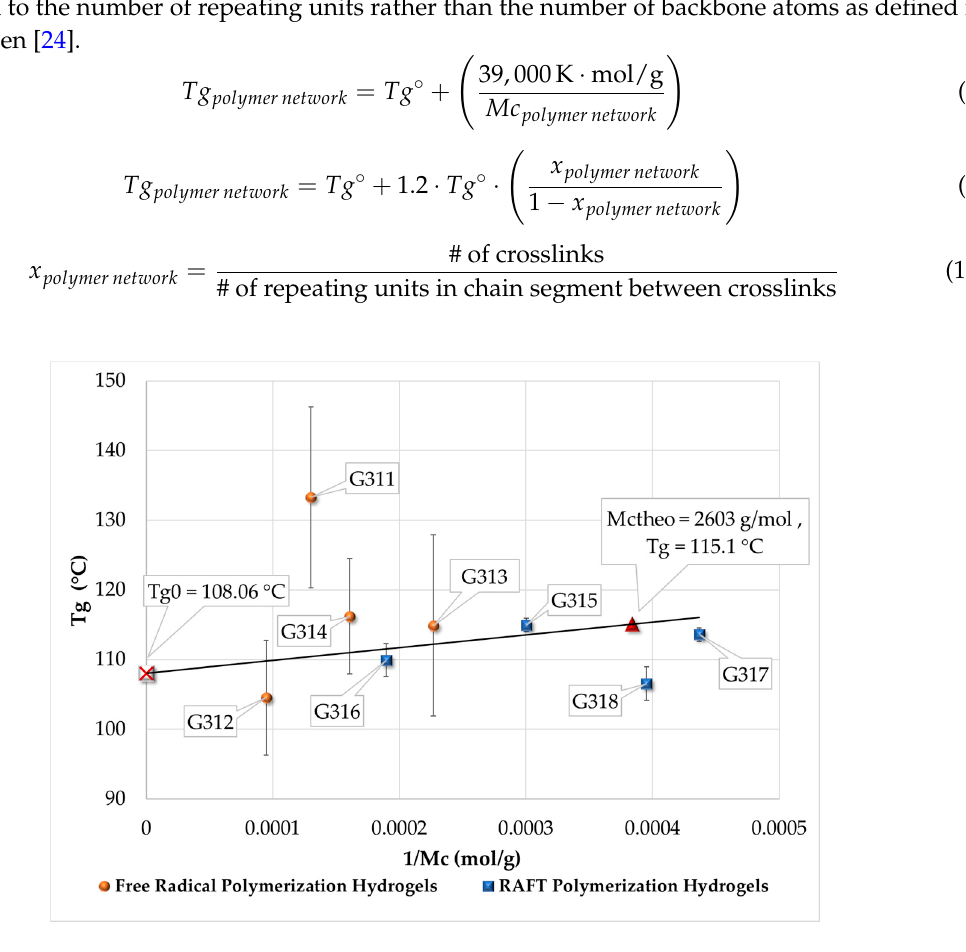
Figure 9. Relationship between Tg measured by modulated differential scanning calorimetry (MDSC) and 1/ Mc for hydrogels synthesized by FRP and RAFT copolymerizations.